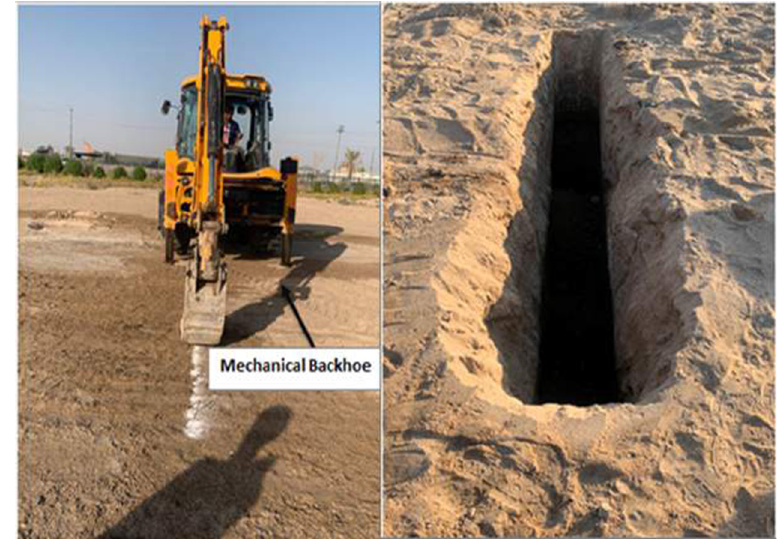
Figure 7: Open trench